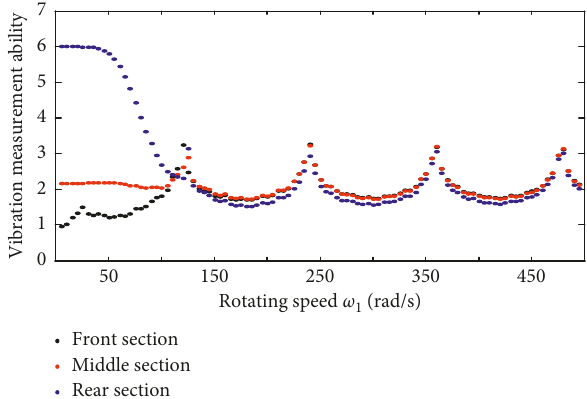
Figure 13: Vibration measurement ability C with varying rotating speed of low-pressure rotor ω l : front section (black), middle section (red), and rear section (blue).